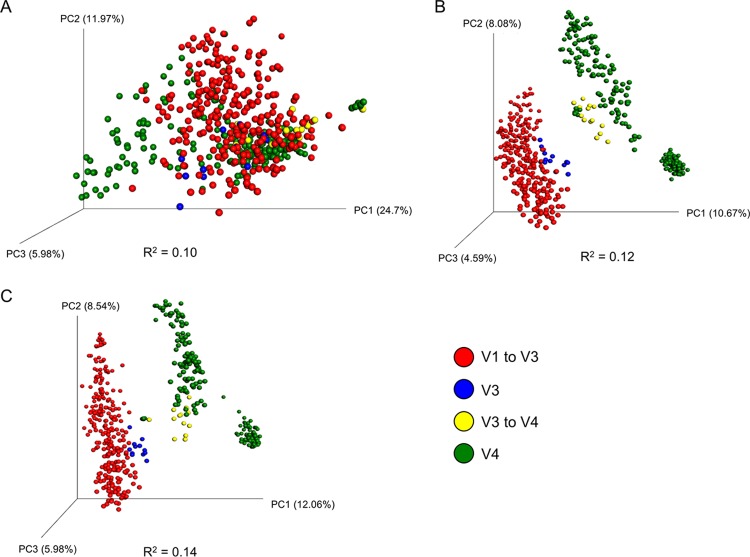
Principal-coordinate analysis plots of weighted UniFrac distances (A), unweighted UniFrac distances (B), and Bray-Curtis dissimilarities (C) classified by hypervariable region sequenced for fecal samples only. Percentages of variation explained by the principal coordinates are indicated on the axes, and the R values on each plot indicate the dissimilarities between the hypervariable region groups.